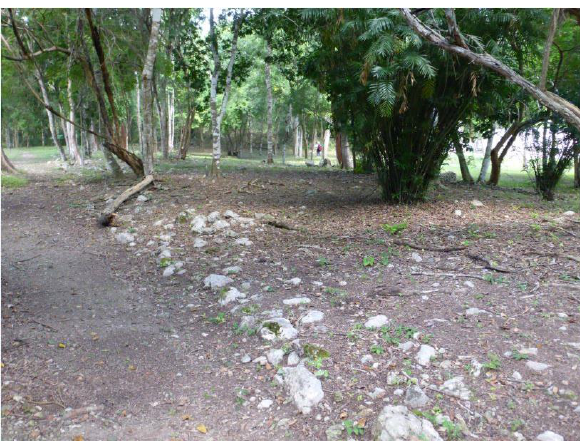
Figure 1. Ground picture of a former sacbe , showing a slightly raised road lined with white